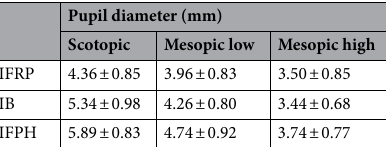
Table 3. Mean pupil size of patients after IFRP, IB and IFPH under 3 different levels of